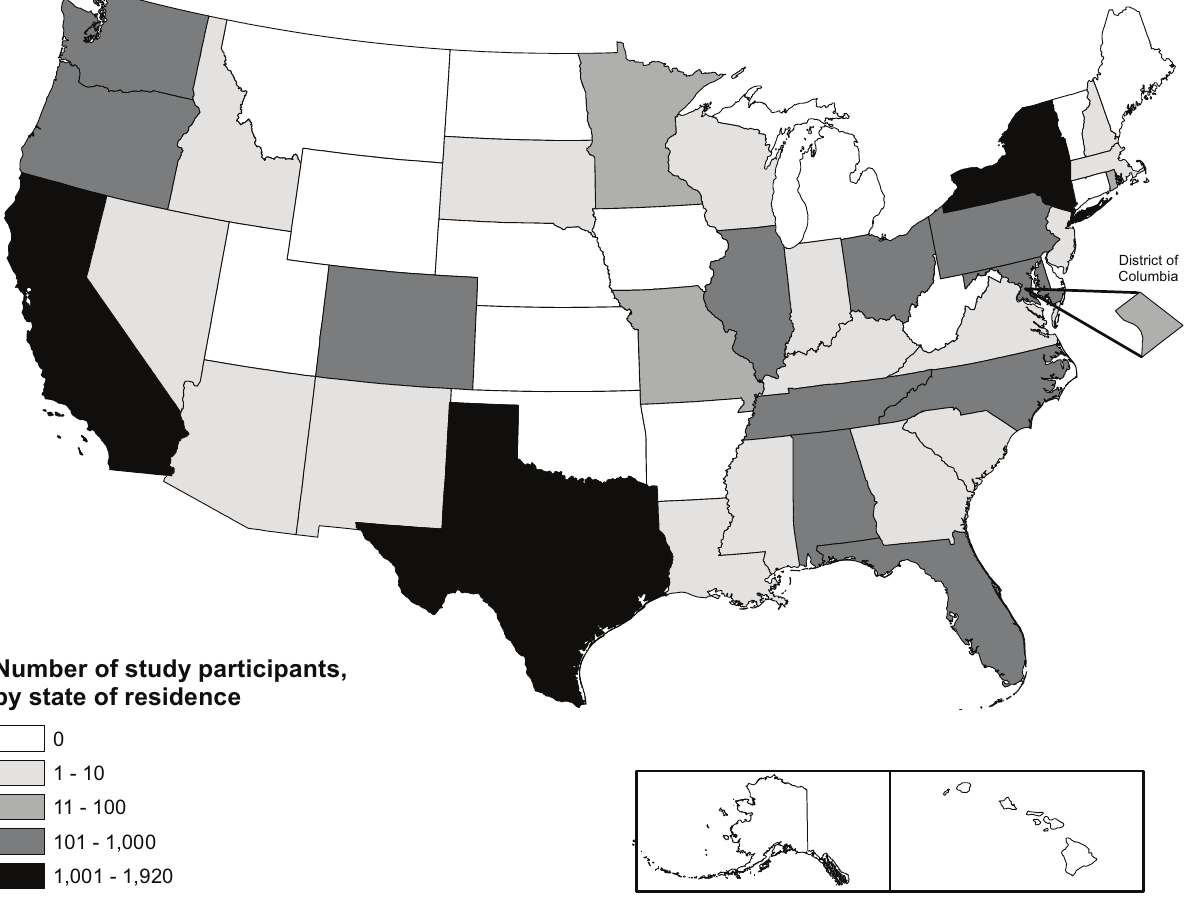
Figure 2. Map of U.S. states represented in study.